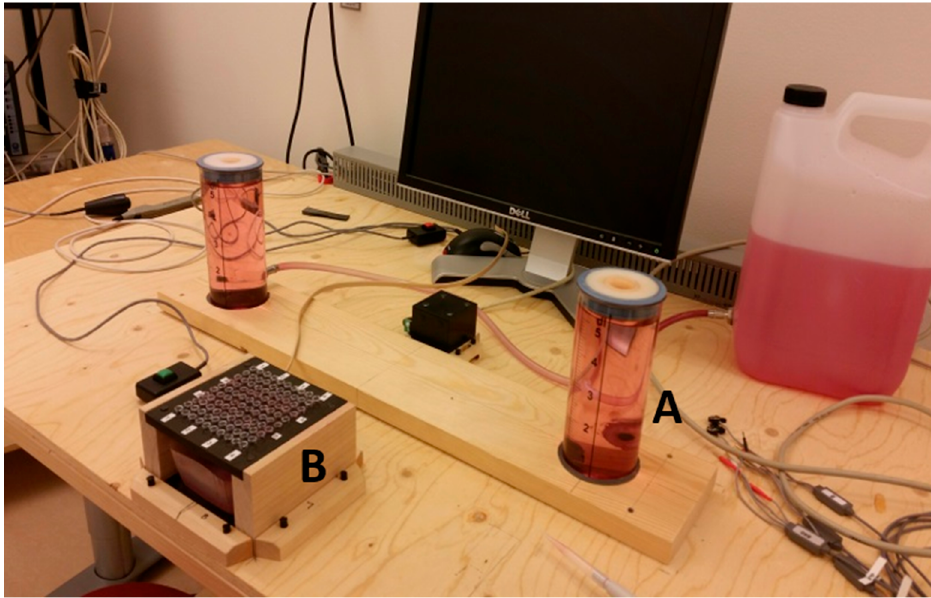
Figure 2. Arrangement of target and pickup tubes; the right, larger tube (A) was the pickup tube, and liquid was to be dispensed into small tubes in the fixture at the front (B).